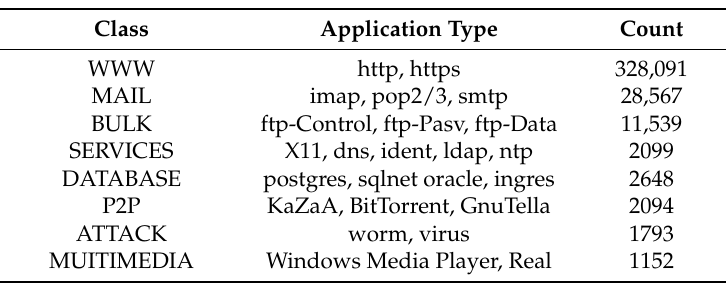
Table 1. The detail of Moore data set.